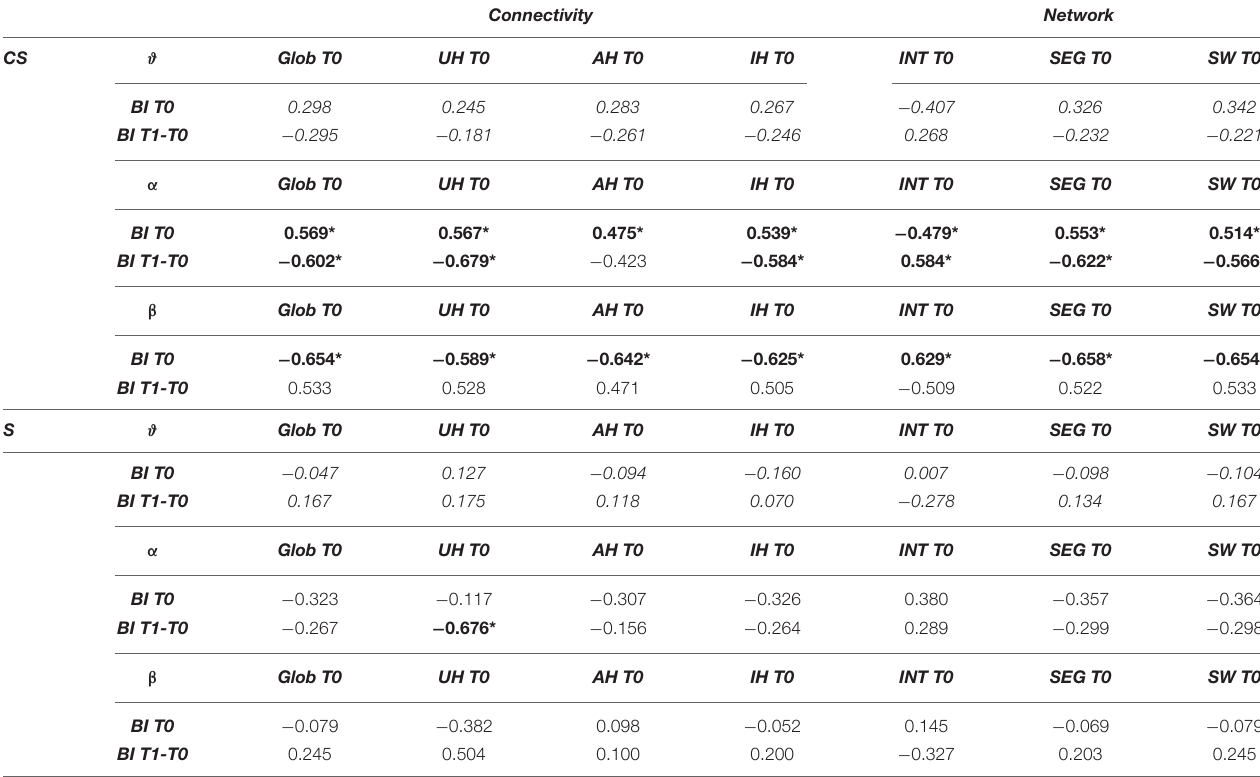
TABLE 3 | Spearman’s correlations between connectivity or network measures and Barthel Index (BI) at T0 or Barthel Index variation (BI T1-T0). Connectivity